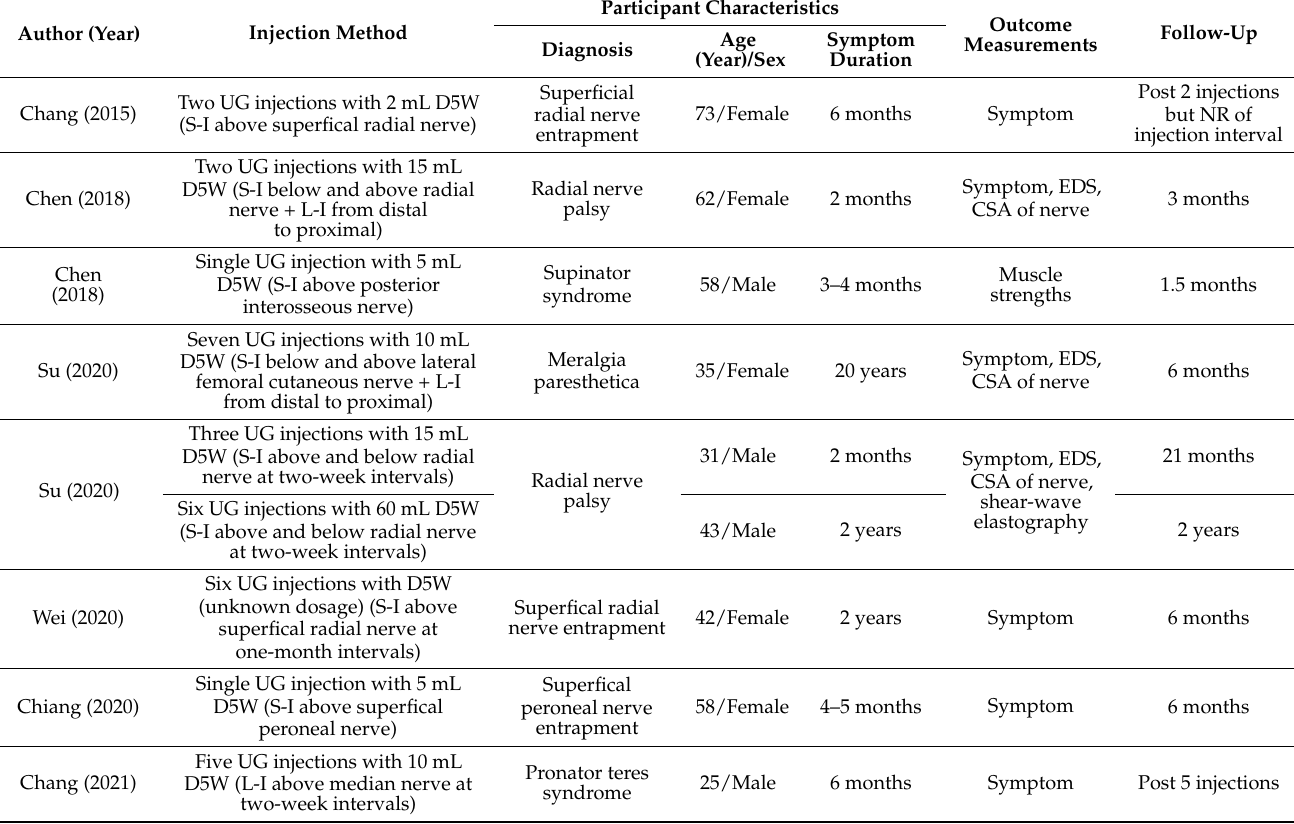
Table 2. Summary of included case